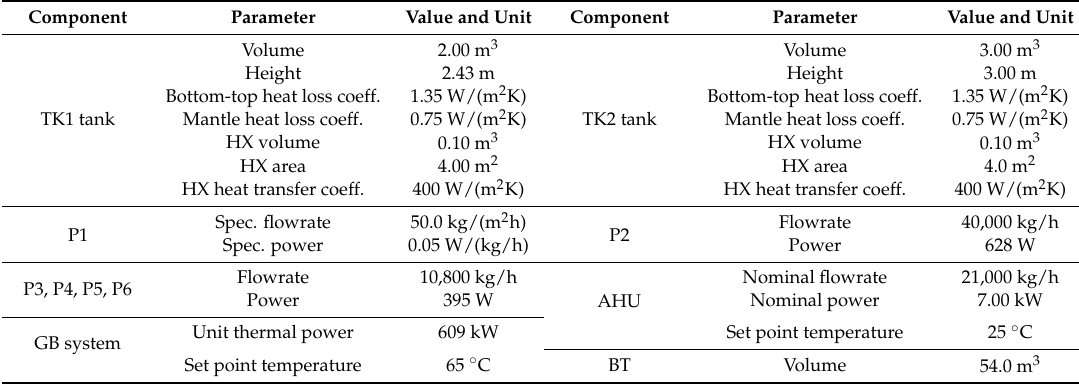
Table 4. Main parameters of the system